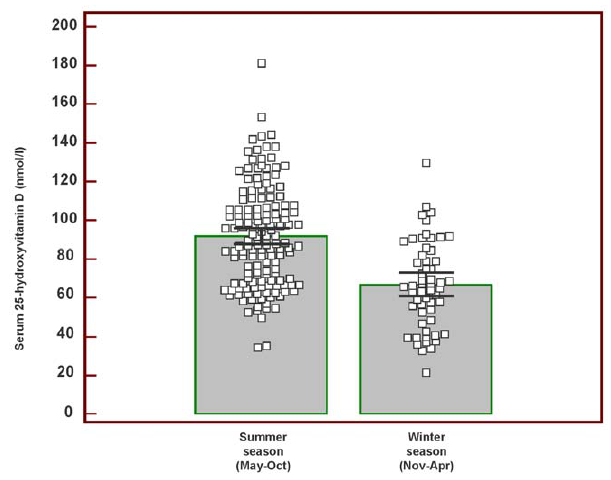
Figure 1. The distribution in serum 25-hydroxyvitamin D by season. Each value is designated by a box. The height of the wide grey bars indicates mean values and the error bars display 95% confidence intervals for the means.